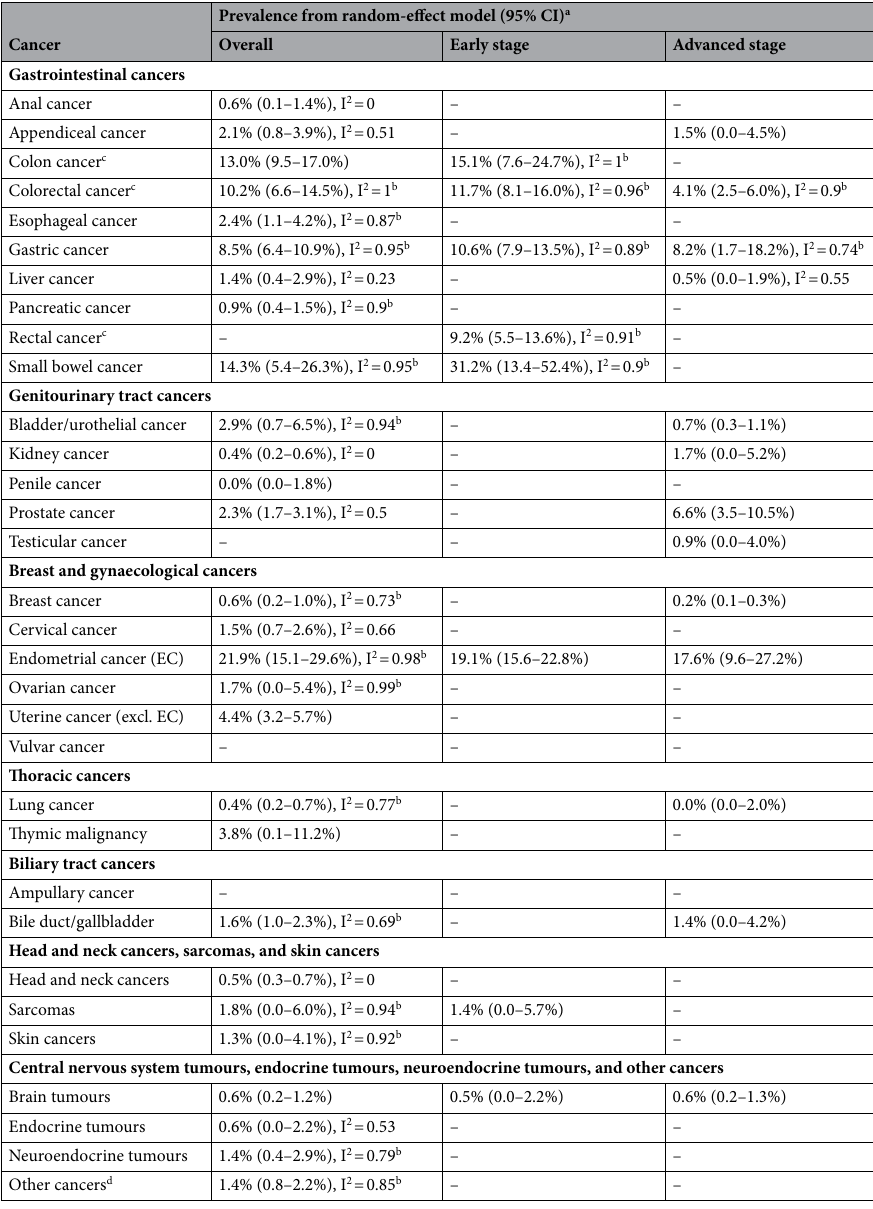
Table 3. Prevalence of microsatellite instability in adult solid tumours by cancer type and stage. a Heterogeneity across studies was presented based on the point estimate of I 2 score and heterogeneity test, if ≥ 2 records were available for each cancer type and stage group. b Statistically significant heterogeneity across studies (p < 0.05). c We analysed the pooled prevalence of pan-tumour biomarkers separately based on estimates including (1) colon cancer only, (2) rectal cancer only, and (3) tumours at any sites in the colon and the rectum, obtaining pooled prevalence estimates described as “colon cancer”, “rectal cancer”, and “colorectal cancer”, respectively. d Other caners include cancer of unknown primary, cancer of unknown primary-neuro, germ cell tumour, peritoneal cancer, and underspecified cancer. See Supplementary Tables S7 and S11 for the number of records included in the analysis and the